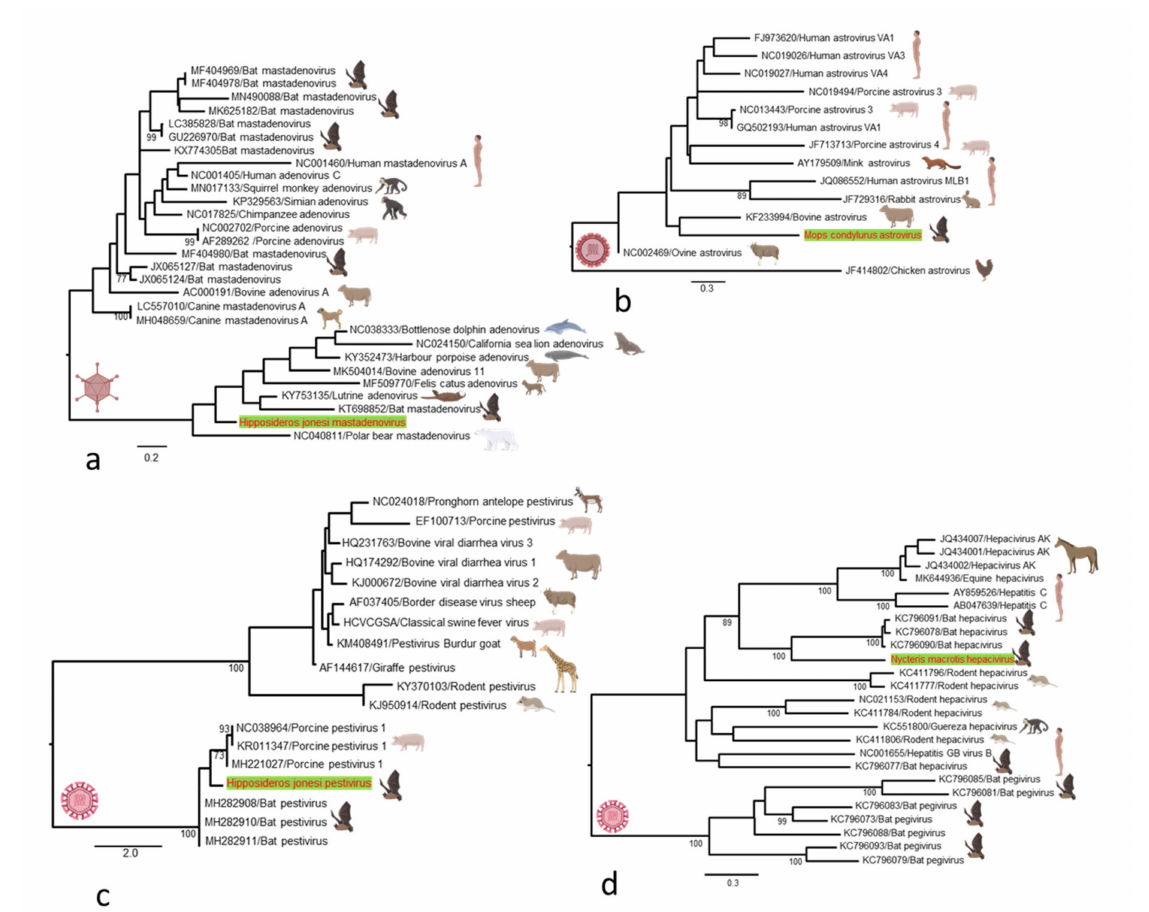
Figure 4. Maximum likelihood phylogenetic trees of viruses detected with representative members that were previously identified in other mammalian and avian hosts. ( a ) Phylogenetic analysis of representative adenovirus species based on the 353 nucleotide (nt) sequence of DNA polymerase gene. ( b ) Phylogenetic analysis of representative astroviruses based on the 267 bp sequence of the ORF1a gene. ( c ) Phylogenetic analysis based on complete P7 gene nucleotide sequences of pestivirus detected in this study compared with other previously identified representatives. ( d ) Phylogenetic analysis based on the 1453 bp sequence of the hepacivirus RdRp gene. All trees are midpoint rooted and scaled to nucleotide substitutions per site. Bootstrap values (70%) are shown at the key nodes. The viral sequences detected in this study are shown in red in each tree. The silhouettes of figures were created with